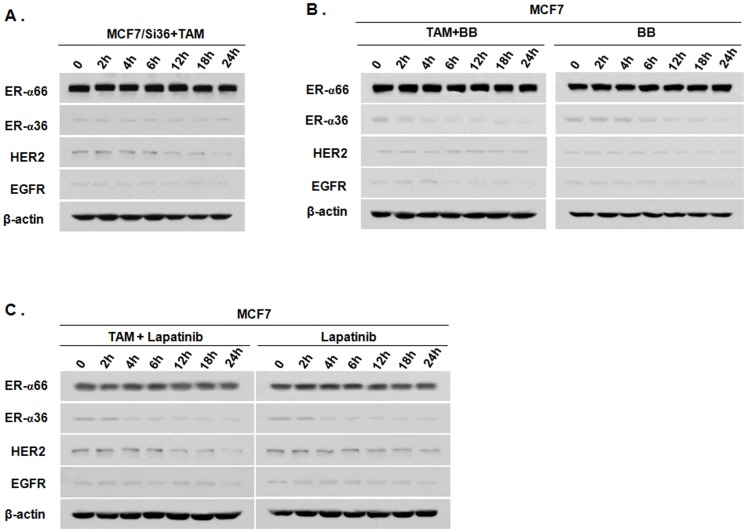
Tamoxifen induces ER-α36, HER2 and EGFR expression via the ER-α36-EGFR/HER2 positive regulatory loops.A. Western blot analysis of the expression levels of ER-α66, ER-α36, HER2 and EGFR in MCF7 cells with knocked-down levels of ER-α36 expression (MCF7/Si36) treated with 1 µM of TAM for indicated time period. B. ER-α66, ER-α36, HER2 and EGFR expression in MCF7 cells treated with 1 µM of TAM together with 1 µM of Broussoflavonol B (BB) for indicated time period. C. Western blot analysis of ER-α66, ER-α36, HER2 and EGFR in MCF7 cells treated with 1 µM of TAM and 1 µM of Lapatinib for indicated time period.